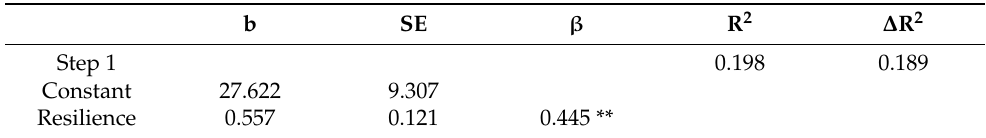
Table 6. Univariate linear regression analysis predicting posttraumatic growth from resilience for all recipients overall.